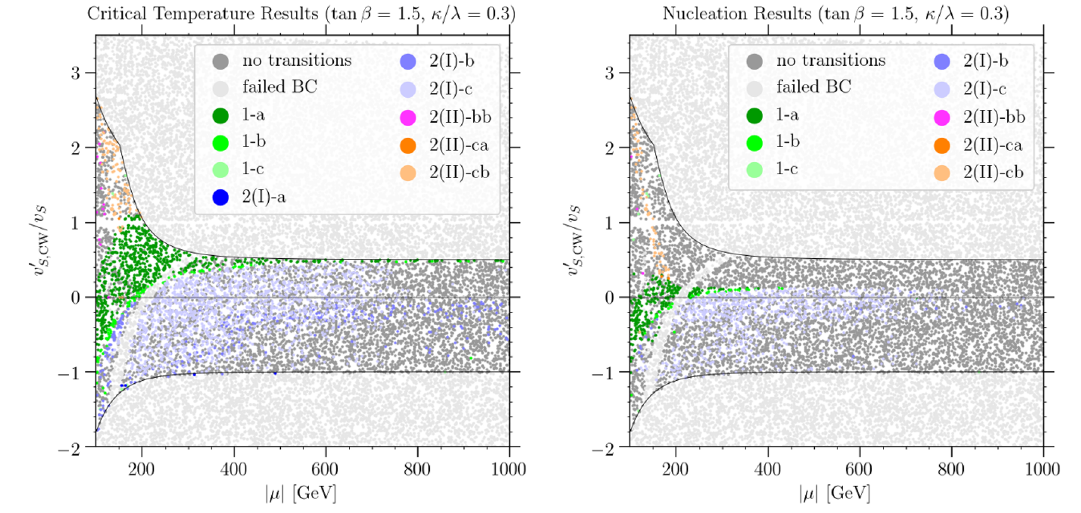
Figure 8 . Same as figure 4, but for tan β = 1 . 5 and κ/λ = 0 . 3 .